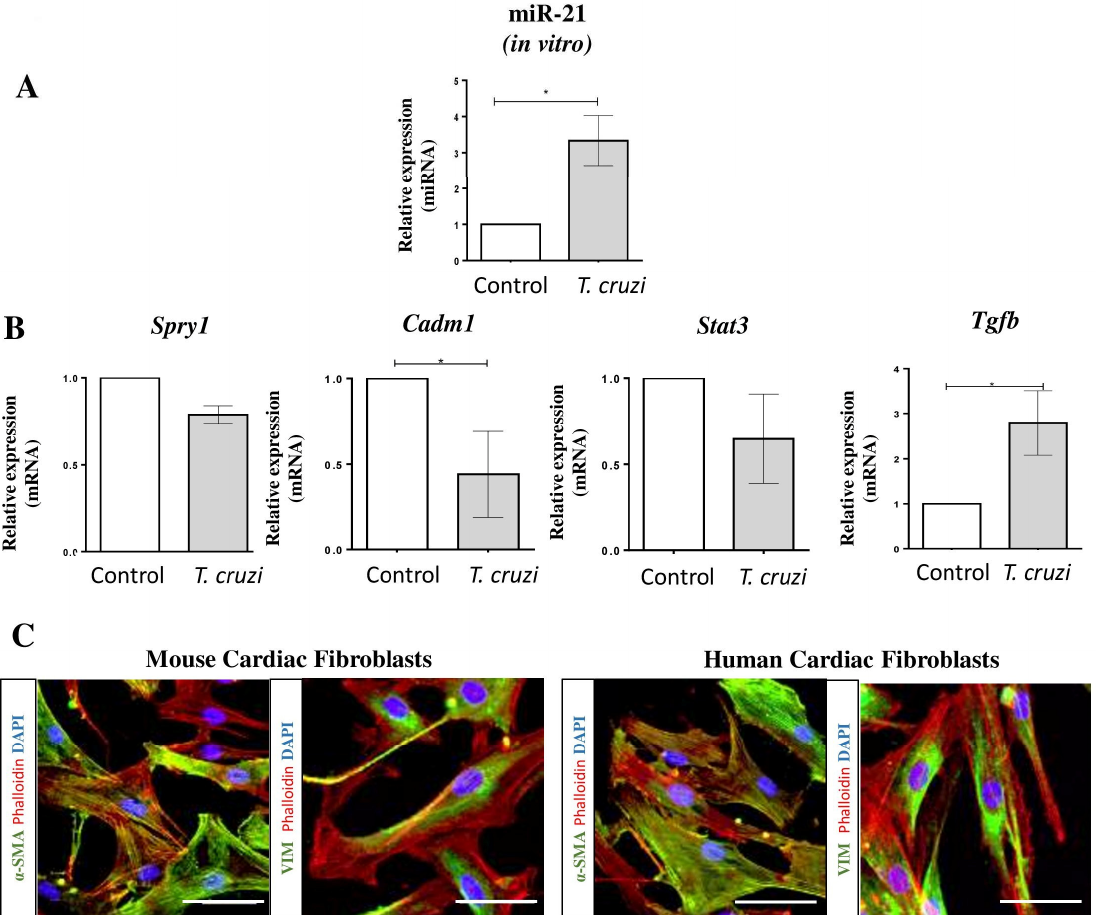
Figure 3. MiR-21 and targets expression after T. cruzi infection in mouse cardiac fibroblasts. ( A ) MiR-21 expression in mouse cardiac fibroblasts 24 h after T. cruzi infection compared with non-infected control. ( B ) mRNA expression of miR-21 targets Spry1, Cadm1, and Stat3 24 h after T. cruzi infection. Tgfb1 mRNA expression was evaluated in vitro after T. cruzi infection in mouse fibroblasts. ( C ) Characterization of mouse and human cardiac fibroblasts by immunostaining for alpha-SMA and Vimentin markers (green), phalloidin (red), and nuclei stained with DAPI (blue). Scale bars = 50 µm. Expression analyses were performed by RT-qPCR (fold change to non-stimulated control), miRNA was normalized to miR-423-3p, and mRNA was normalized to HPRT/GAPDH. Data are expressed as mean ± SEM of three independent experiments performed. * p < 0.05, Student’s t-test.